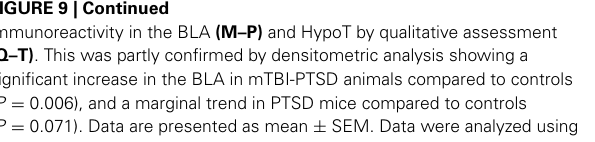
astrogliosis (B) . In some cases these perivascular astroglial cells appeared hypertrophic with a large cell soma and thick cellular processes (B–D) . A distinct remarkable astrogliosis was observed in the walls of the ventricles (gray arrows— E ) and the neighboring adjacent brain parenchyma (E,F) . Abbreviation; blood vessel (B.V). Scale bar represents 120 μ m in all